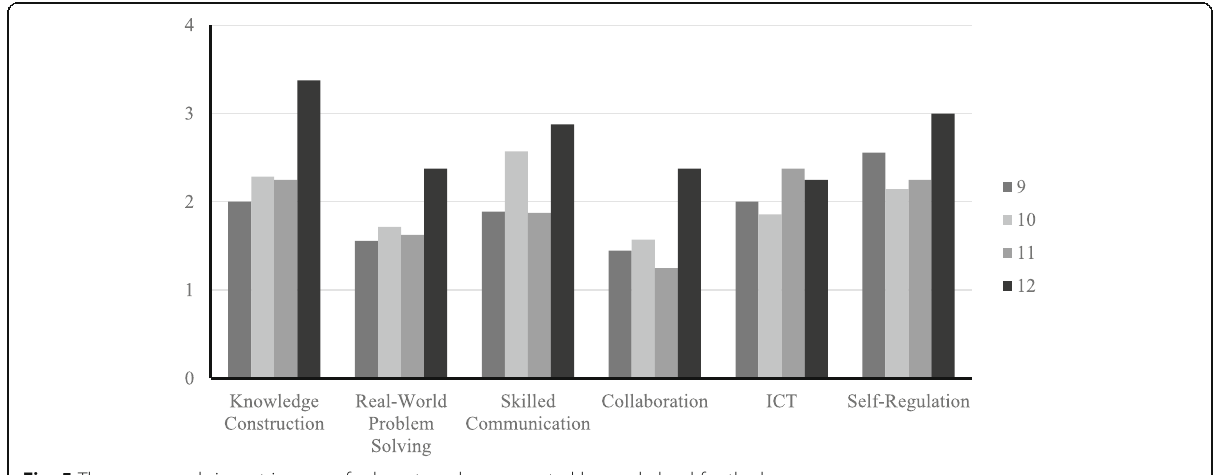
Fig. 5 The average rubric metric scores for long-term lessons, sorted by grade level for the lesson